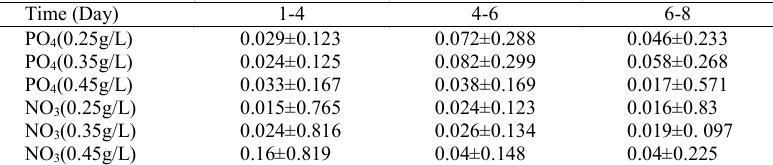
Table 2: Mean specific growth rate trend in the treatments of Chlorella vulgaris Time (Day) 1-4 4-6 6-8 PO 4 (0.25g/L) 0.029±0.127